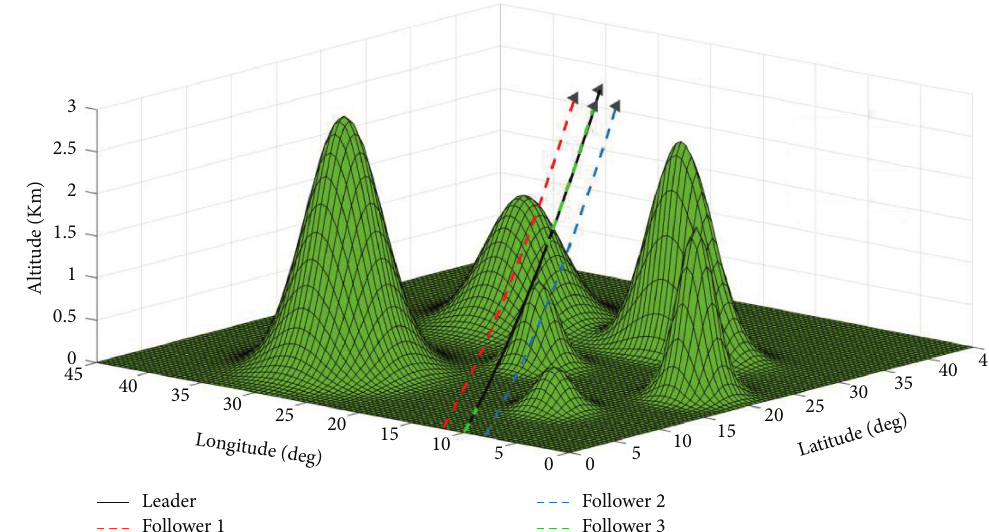
Figure 13: Trajectory navigated by the